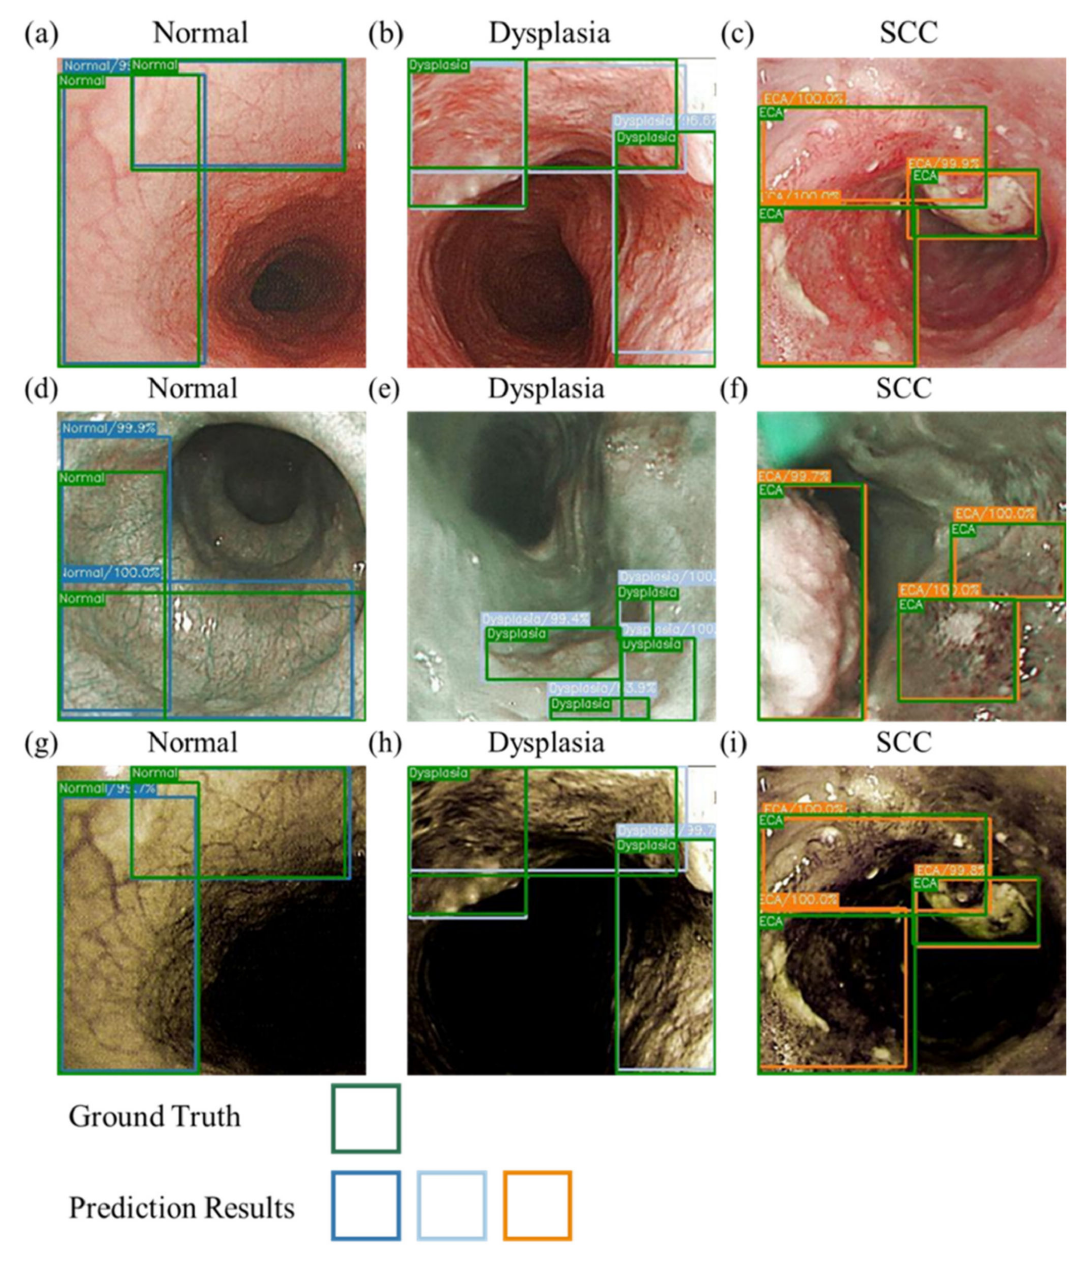
Figure 3. Schematic of the prediction results for WLIs, NBIs, and HSI images. ( a – c ) are the WLI prediction results. ( d – f ) are the NBI prediction results. ( g – i ) are the HSI prediction results. ( a , d , g ) are the normal period, and the green and blue boxes represent the real and predicted frames, respectively. ( b , e , h ) are the dysplasia period, and the green and gray boxes represent the real and predicted frames, respectively. ( c , f , i ) are the SCC period, and the green and orange boxes represent the ground truth box-predicted boxes,